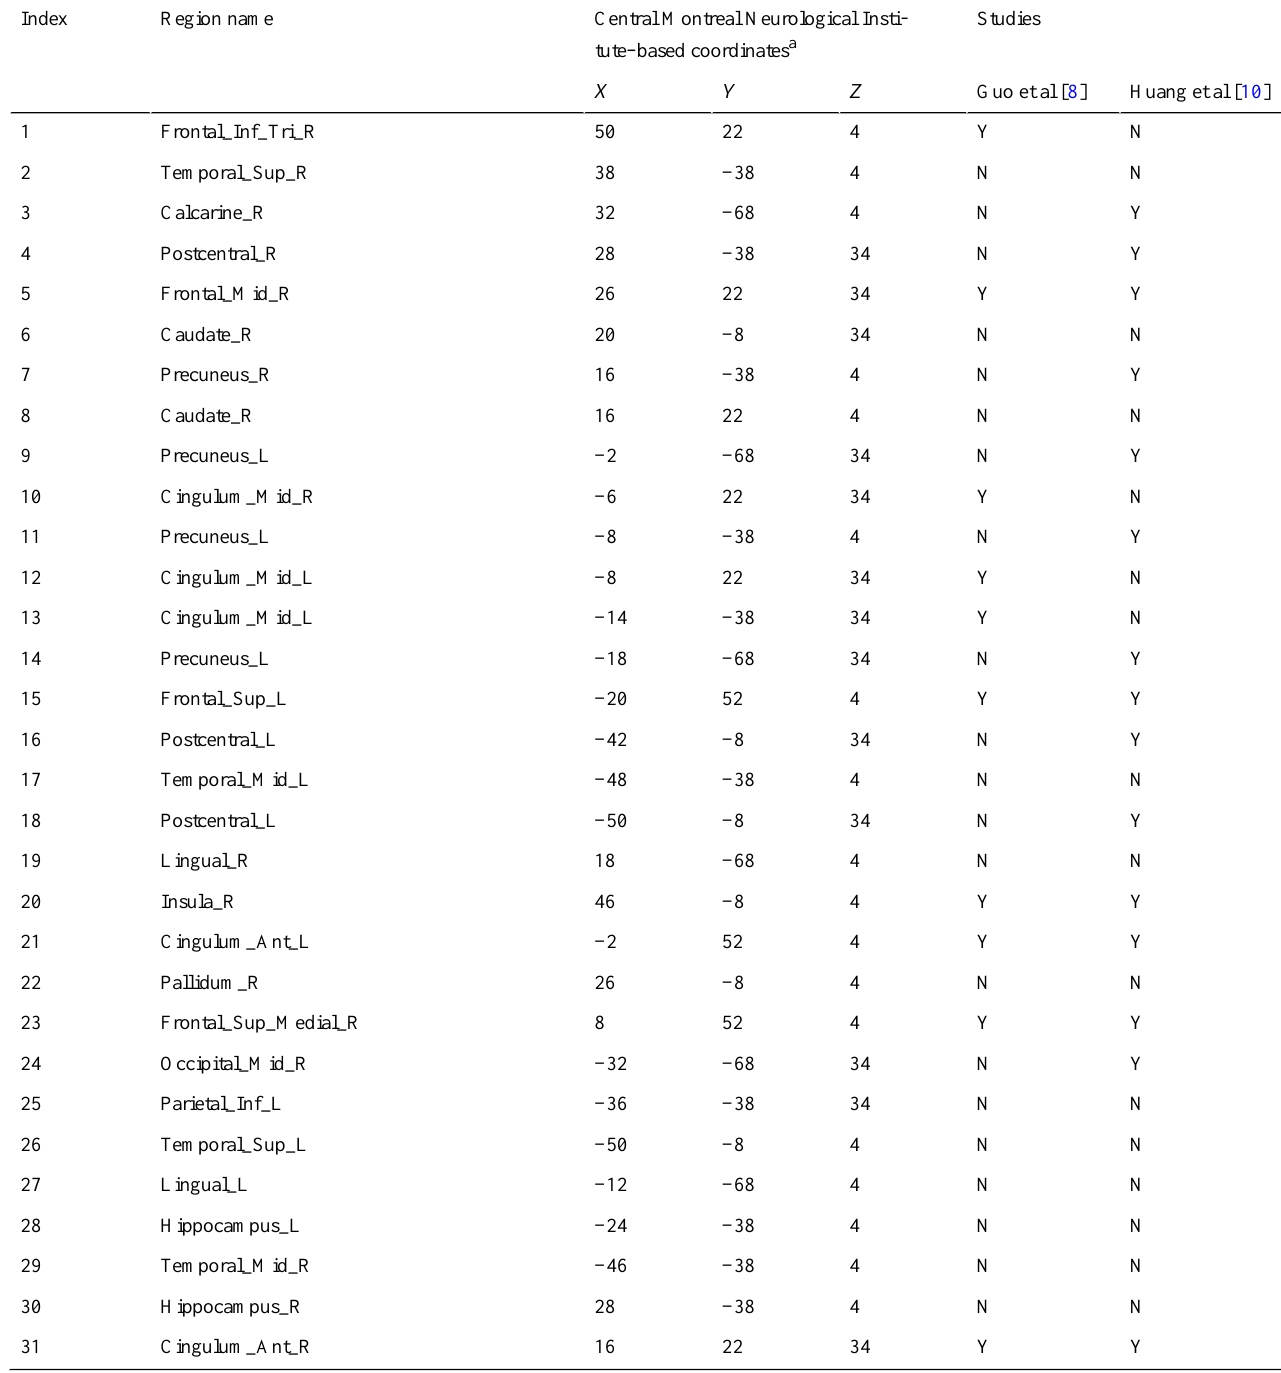
Table 5. Autism spectrum disorder–related anatomical automatic labeling brain regions identified by a histogram-based morphometry framework on the ETH